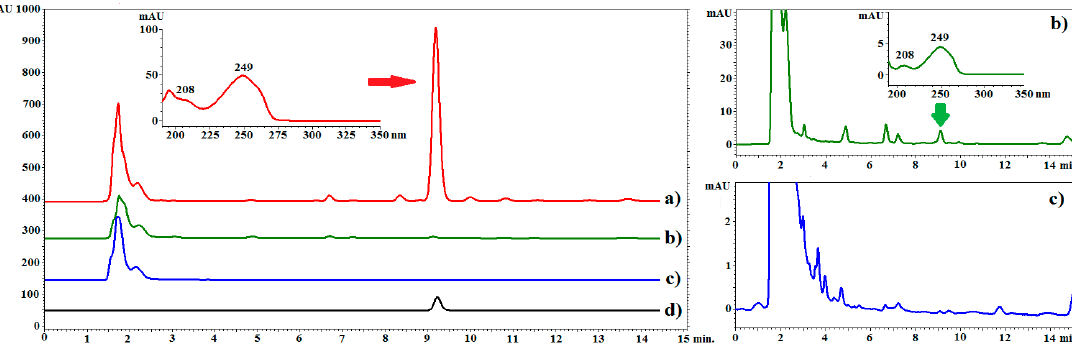
Figure 2. Example chromatograms of C. acaulis extracts and the reference compound. Line ( a ): chromatogram of the root extract of plants growing in soil; line ( b ): chromatogram of the extract from the roots of plants grown in hydroponics, line ( c ): chromatogram of the extract from callus, line ( d ): chromatogram of the standard solution (carlina oxide). LiChrospher 100 column, acetonitrile–water (65:35 v / v ), flow rate of 1.0 mL/min at 20 °C. λ = 249 nm.